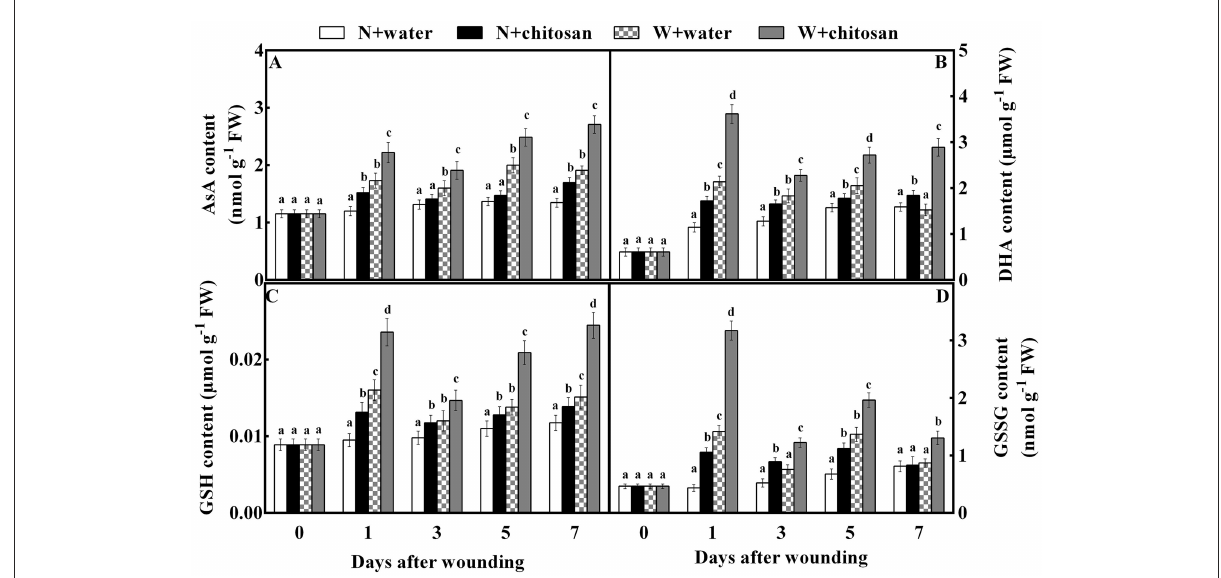
FIGURE5 Effect of chitosan treatment on the contents of AsA (A) , DHA (B) , GSH (C) , and GSSG (D) at apple wounds. Non-wounded fruit treated with sterile water (N + water), non-wounded fruit treated with chitosan (N + chitosan), wounded fruit treated with sterile water (W + water), and wounded fruit treated with chitosan (W + chitosan). Vertical bars indicate standard error of means. For each day after wounding, alphabets indicate significant differences ( P <